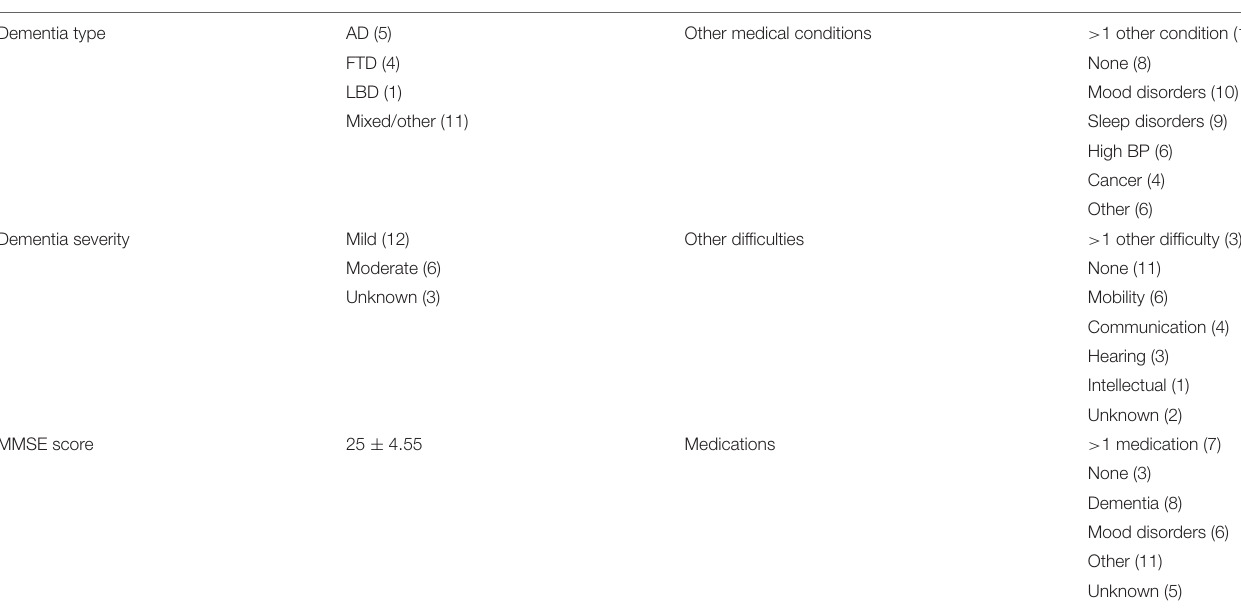
TABLE 2 | Additional characteristics of people living with dementia. Dementia